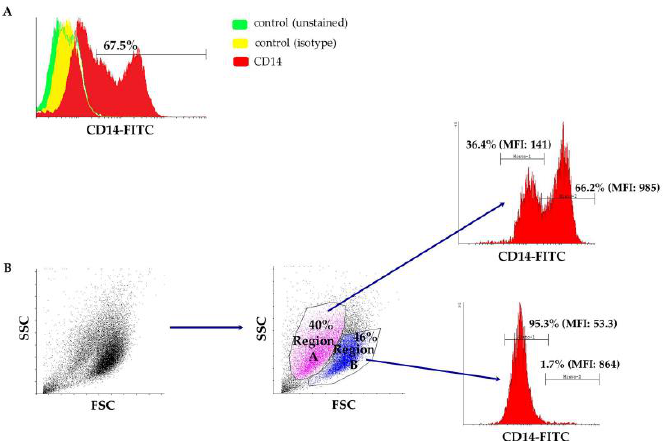
Figure 2. ( A ) A representative flow cytometry overlaid histogram showing the differentiation pattern of cultured cells towards the macrophage lineage (CD14 + ). Unstained cells (green histogram), as well as an FITC-conjugated mouse IgG1 isotypic antibody (yellow histogram) served as negative controls. ( B ) A representative flow cytometry dot plot depicting the two distinct cell populations that express different levels of the CD14 antigen. FITC: fluorescein isothiocyanate; FSC: forward scatter; SSC: side scatter.